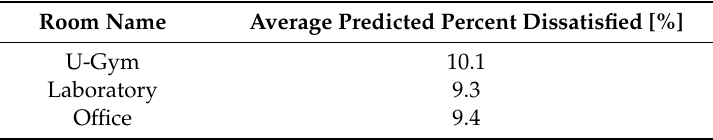
Figure 16. Room temperature profiles in the case of comfort temperature tracking and energy consumption minimization. Figure 16 highlights how the room temperatures attempt to track the optimal comfort temperature during the period of occupancy of the building (8 a.m. – 6 p.m.); the temperature profiles follow the comfort temperature less effectively than in the previous case, because, in this case, the objective function has two conflictual goals, the comfort tracking and the minimization of HVAC